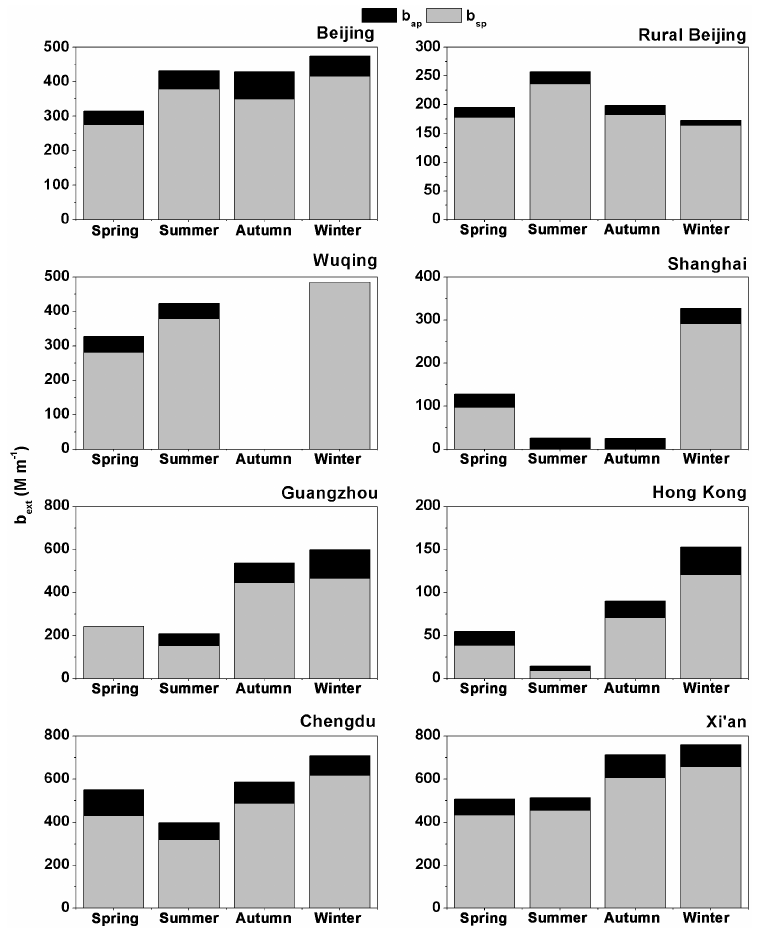
Figure 13. Seasonal b sp and b ap in cities with